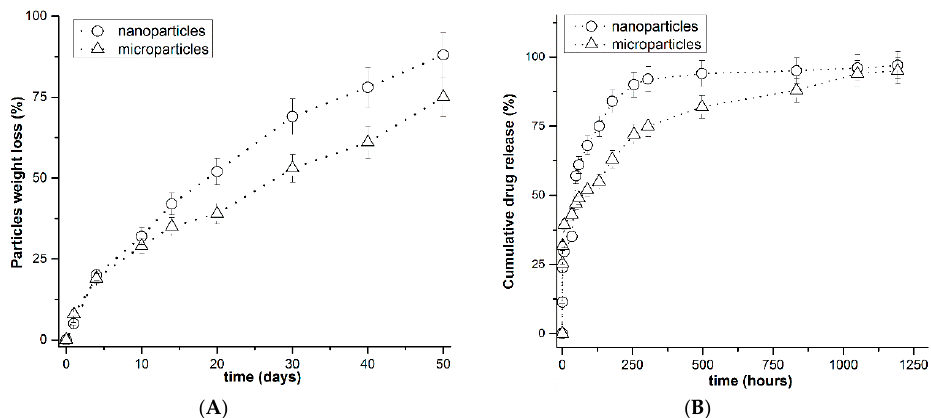
Figure 2. Kinetic curves of PLA particle weight loss ( A ) and perchlozone release ( B ). Conditions: 0.01 M phosphate-buffered saline (PBS), pH 4.5 containing 0.1% SDS and 0.5 mg/mL papain. The standard deviation is given as error bars.